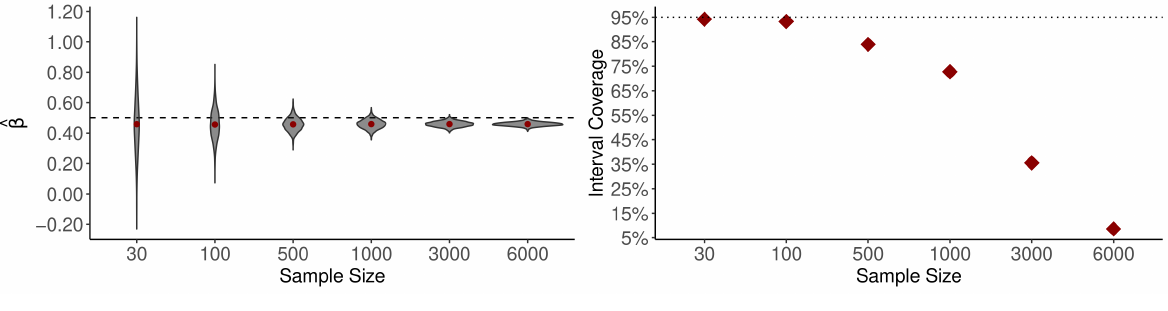
Figure 5. Bivariate regression coefficient estimates from simulated data with additive measurement error. For each of M = 5000 iterations, n = { 30,100,500,1000,3000,6000 } values of x were drawn, x ∼ N ( 0,1 ) ; y i was calculated as α + x i ∗ β + e i where e i ∼ N ( 0,1 ) and β = 0.5; then y was regressed on z , where z i = x i + u i , u i ∼ N ( 0,0.3 )